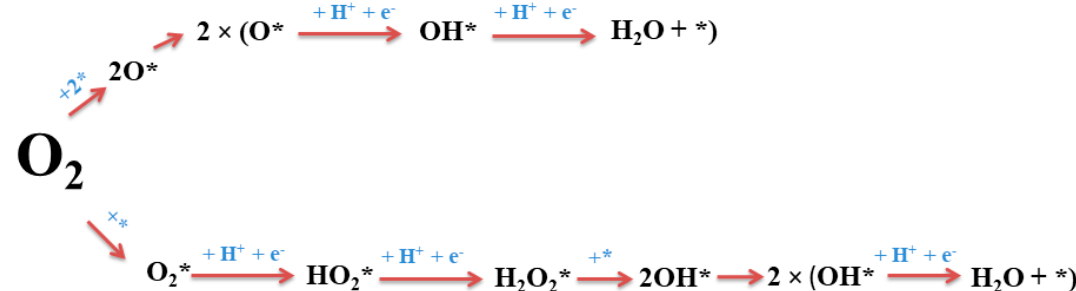
Scheme 1. Possible oxygen reduction mechanisms, * refers to adsorbed